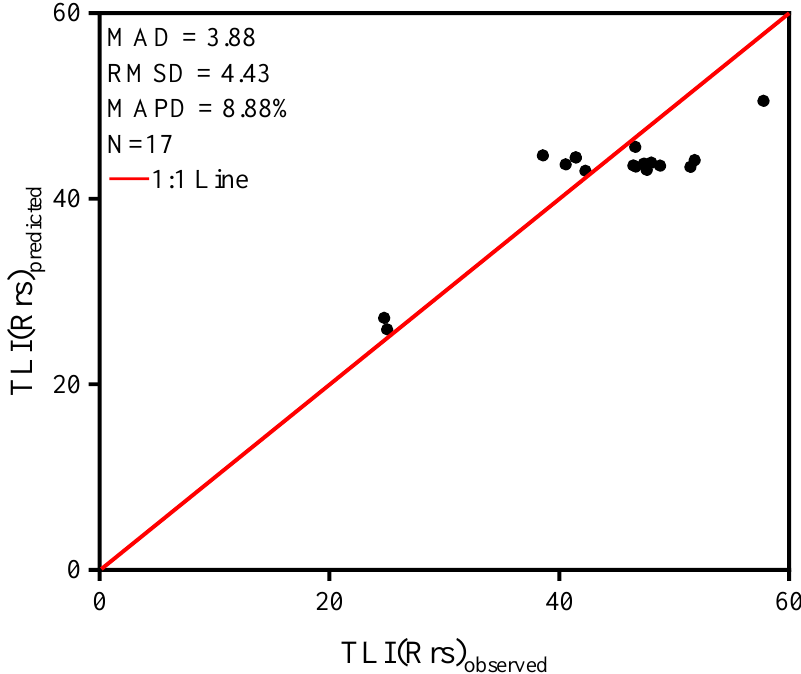
Figure 6. Accuracy validation of TLI model.